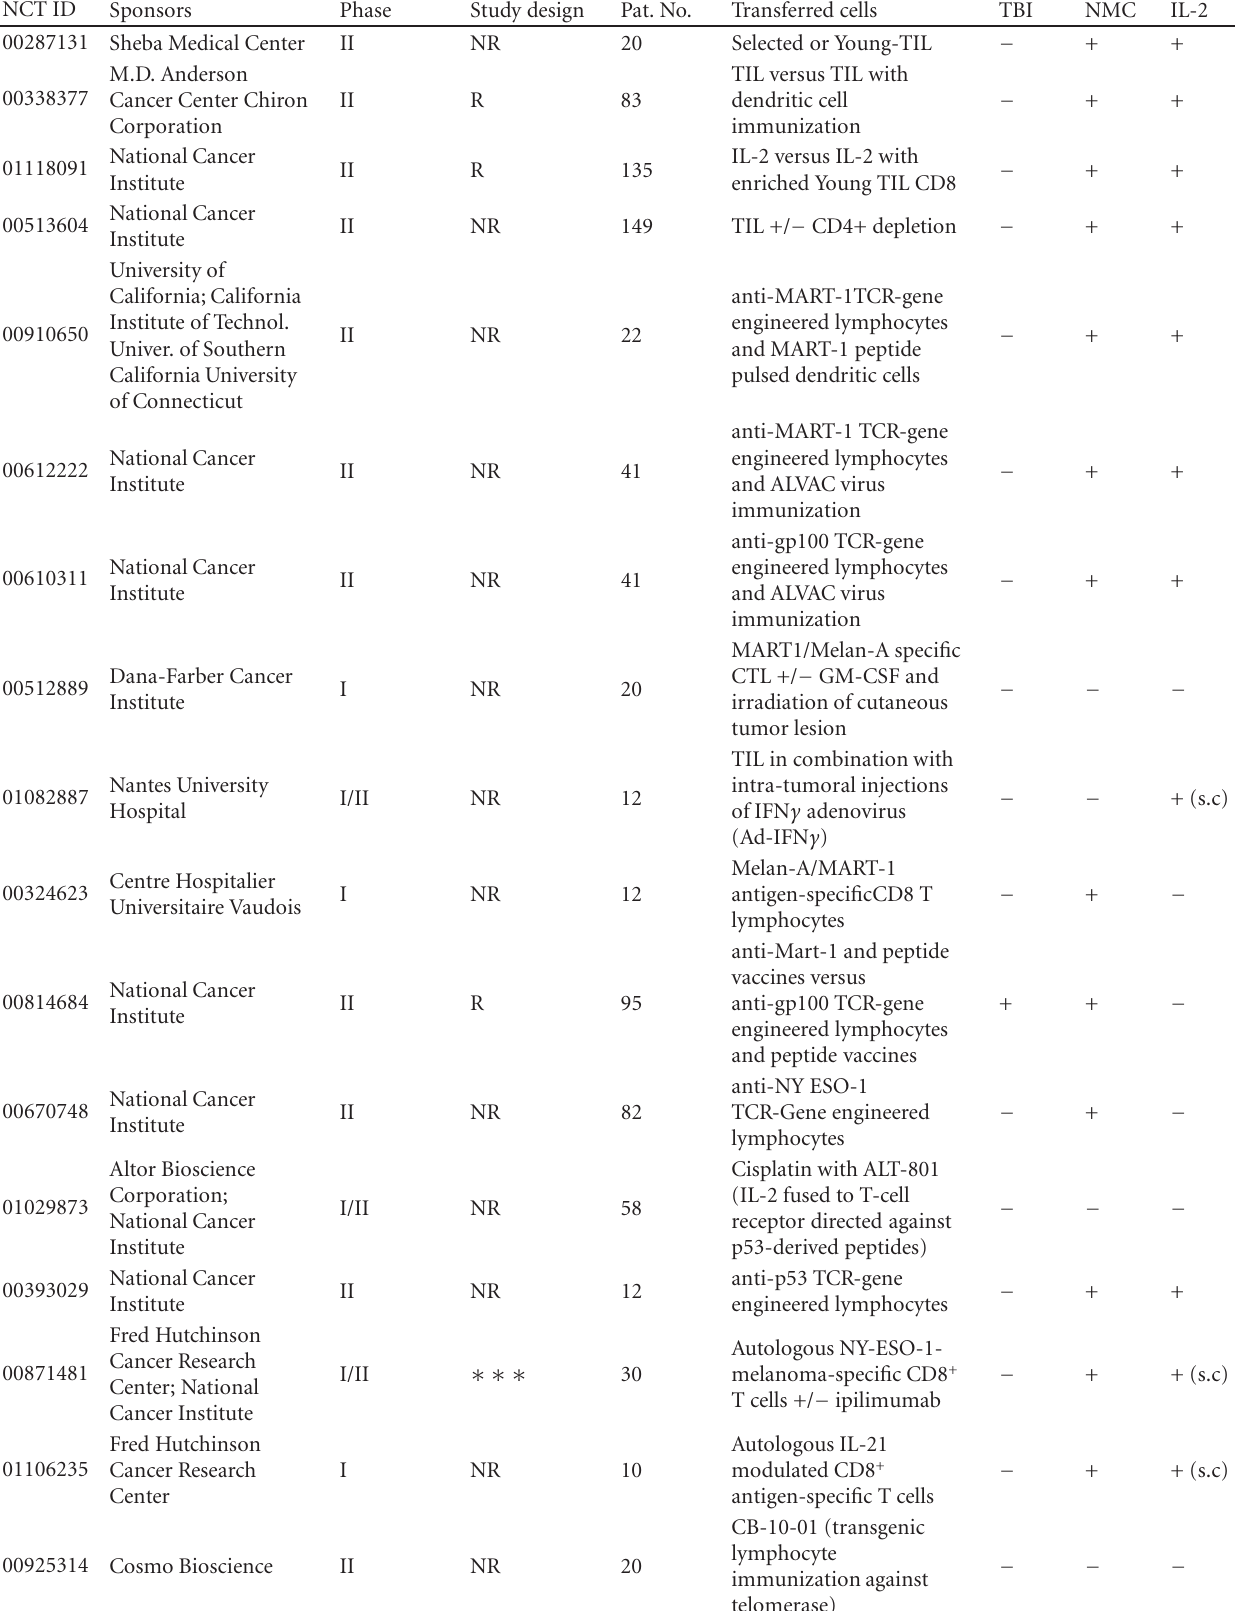
Table 2: Adoptive T cell transfer trials currently recruiting